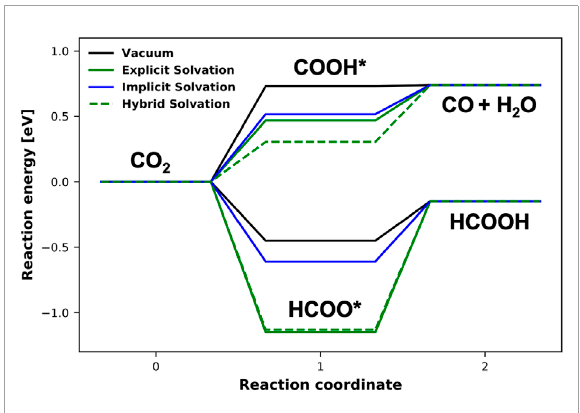
FIGURE 6 Reaction energy diagram for CO 2 reduction towards HCOOH and CO on the Pb(100) surface, computed in vacuum as well as with the implicit/explicit/hybrid solvation